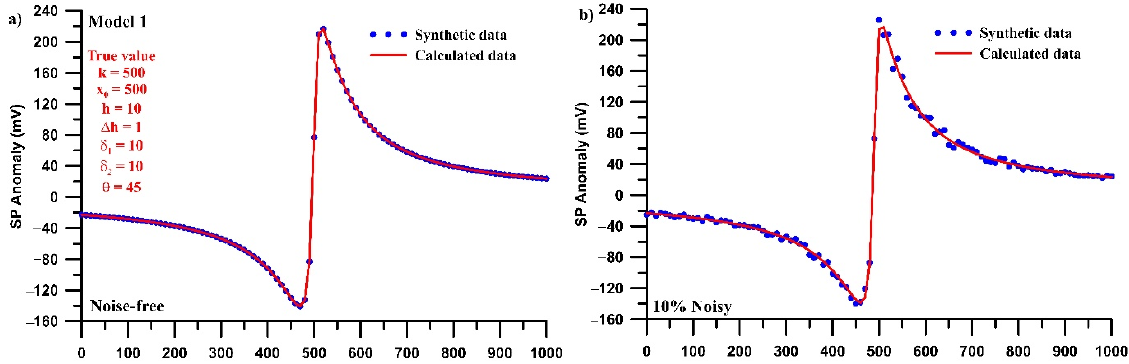
Figure 5. Fits for Model 1: ( a ) Noise-free and ( b ) Noisy synthetic data.